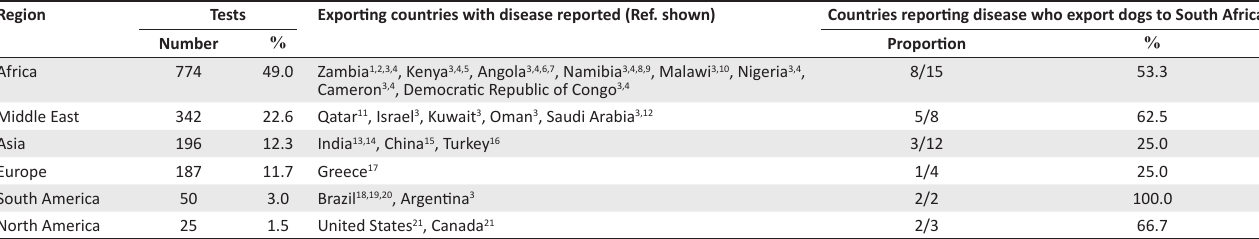
TABLE 1: Canine Leishmania serological tests (IFAT) performed for dogs for importation into South Africa (1574). Region Tests Exporting countries with disease reported (Ref. shown)